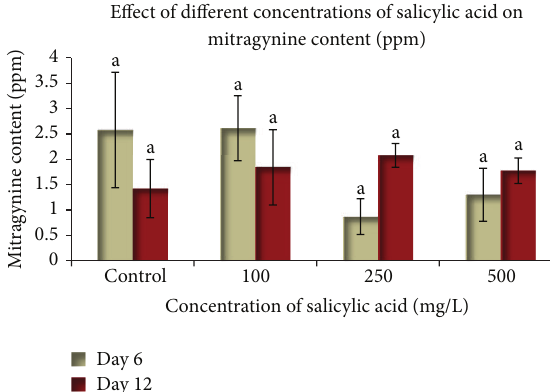
Figure 5: The effect of different yeast extract concentrations at different culture times on the mitragynine content in the Mitrag- yna speciosa suspension culture. The bars indicate standard error. ∗ Valueswiththesamelettersarenotsignificantlydifferentaccording to Duncan’s multiple range test.